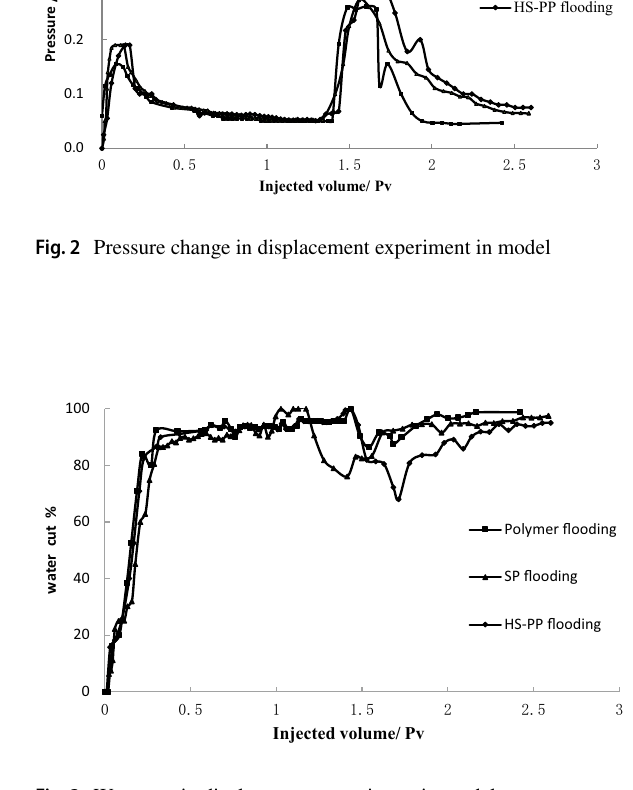
Fig. 3 Water cut in displacement experiment in